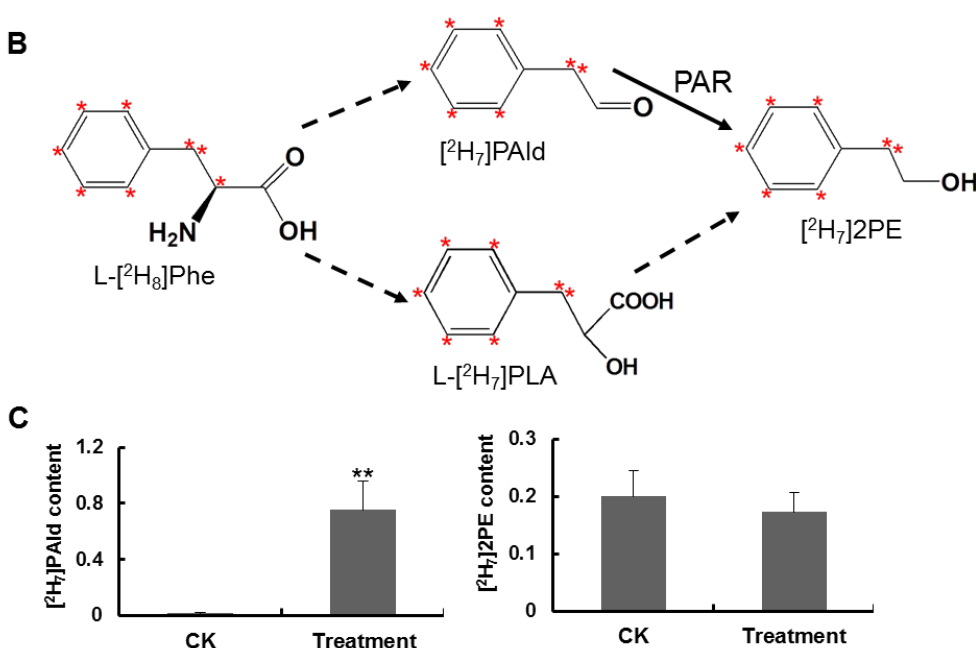
Figure 4. Aroma compound concentrations in phenylalanine degradation pathway Phe, phenylalanine; PAld, phenylacetaldehyde; 2PE, 2-phenylethanol; PAR, phenylacetaldehyde reductase. ( A ) Aroma compound concentrations in phenylalanine degradation pathway during the enzymatic reaction of black tea; ( B ) The known pathway of L-phenylalanine degradation; ( C ) Identification the transformation of L-phenylalanine to aroma compound with [ 2 H 8 ] L-phenylalanine. Data shown as the mean ± SD ( n = 3). ** p < 0.01 vs. CK. Bars indicate the means ± S.D. ( n = 3) of three biological replicates, and bars with di ff erent letters are significantly di ff erent at p ≤ 0.05 according to Duncan’s multiple range